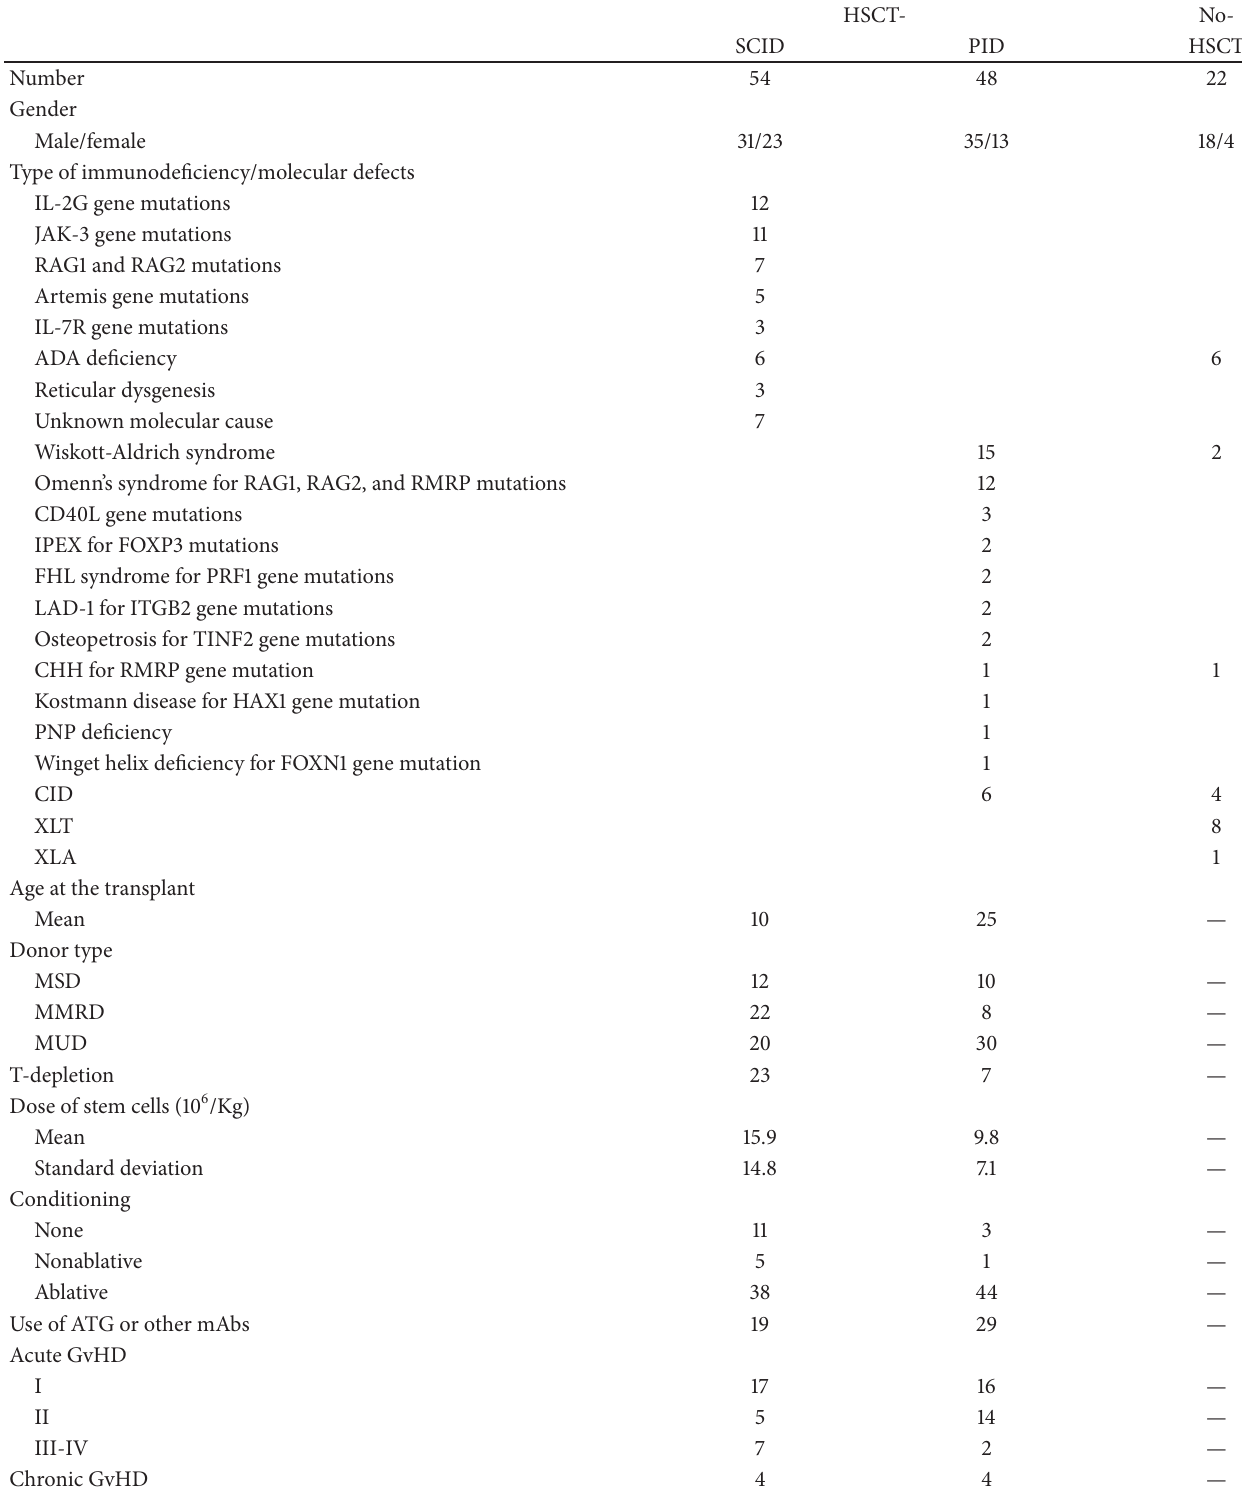
Table 1: Characteristics of the patients included in the study and of the